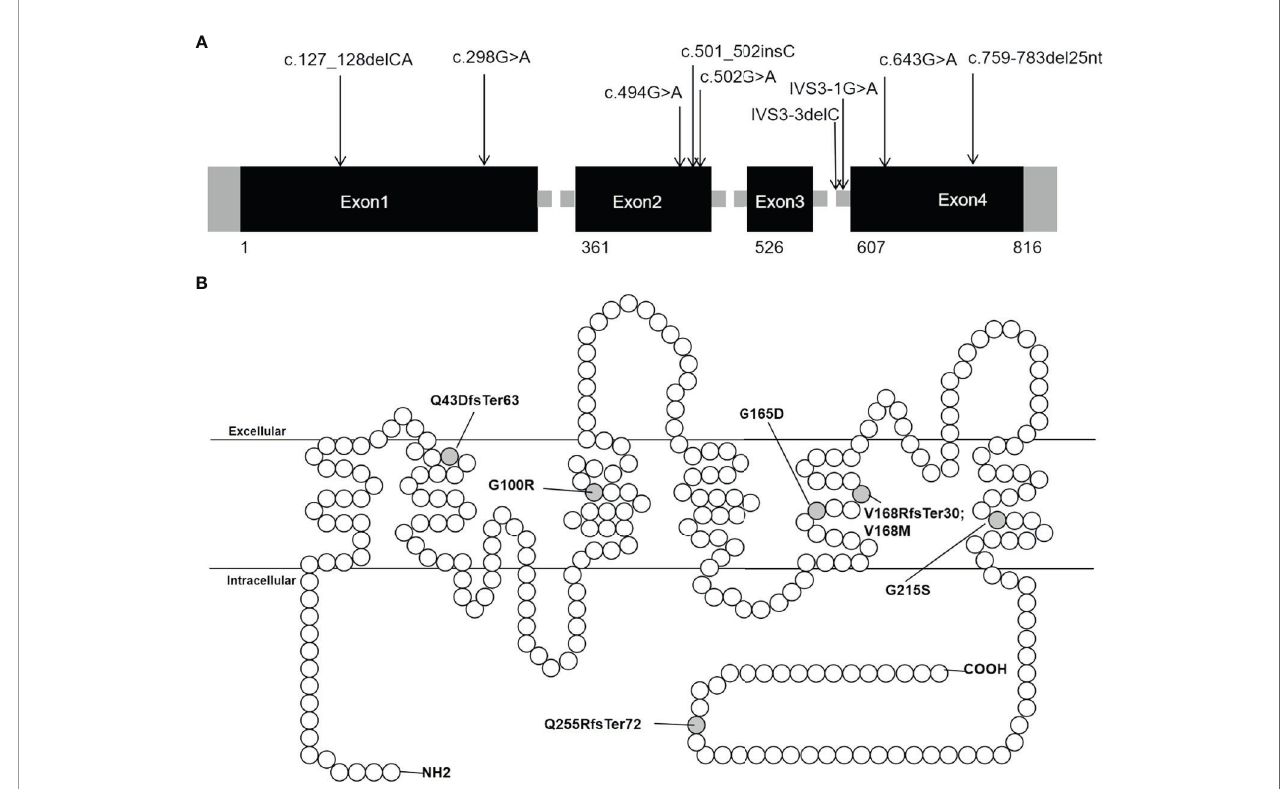
FIGURE 2 | Distribution of AQP2 mutations detected in our patients with NDI. (A) Distribution of the nine mutations in AQP2 gene. (B) Schematic diagram of the primary structure of AQP2, showing the location of changed amino acid. The black rectangles indicate DNA coding sequence; the empty circles indicate amino acid of AQP2 ; the grey half- fi lled circles indicate amino acid alterations found in our study.